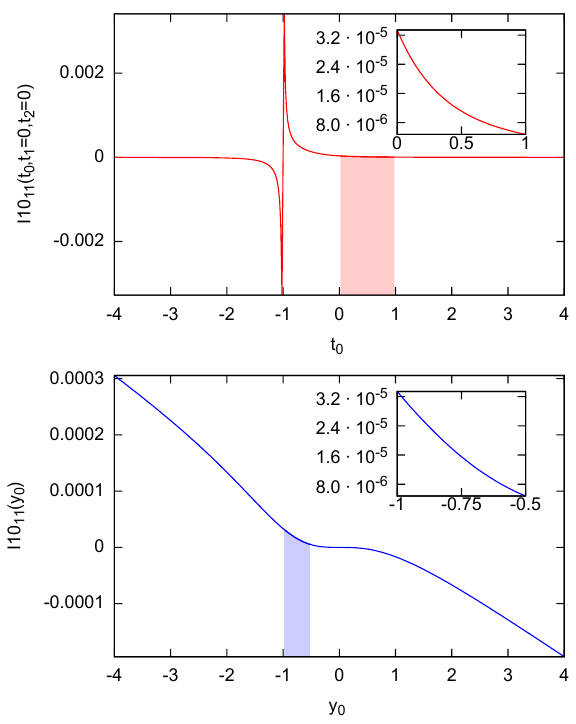
Figure 4 . Plot of the one dimensional integrand of eq. (3.6), before and after the conformal mapping. The integration region is shaded and also shown in the inset plots. The masses are set to m 1 = 173 GeV and m 2 = m 1 p 2